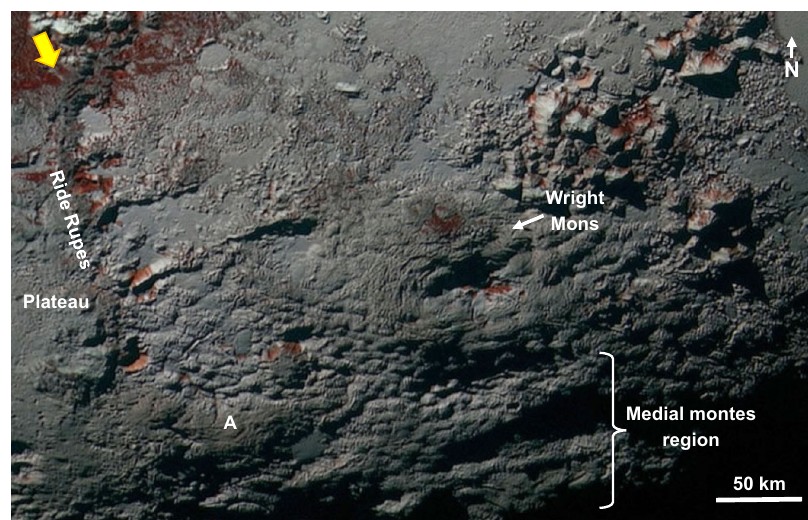
Fig. 3 Color information for the Wright Mons region. Darker/lower albedo, redder patches exist primarily on north-facing slopes but there are also more subtle differences in albedo and redness across the region. The region labelled “ A ” represents a redder unit transition to less red units at lower elevation (described in the text and methods). From the New Horizons observation PEMV_P_Color2 (~660 m px − 1 ) shown in the original image geometry. The longitude and latitude extents of the image are ~160 – 182°E and ~13 –